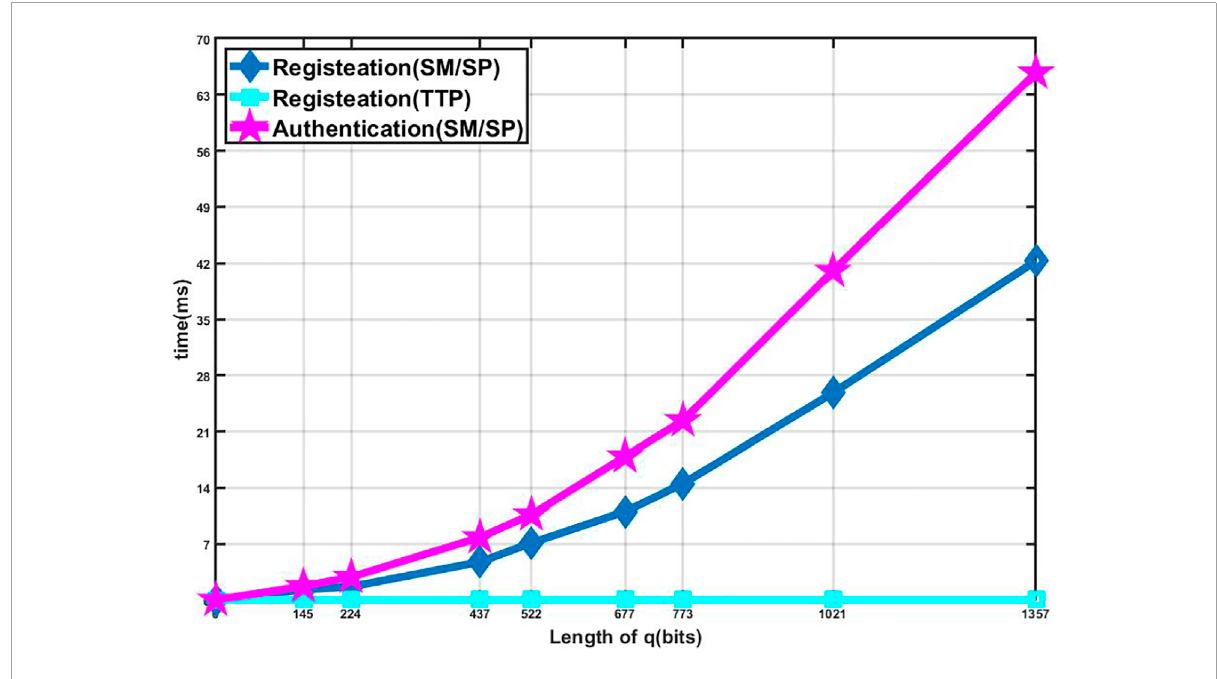
FIGURE 5 Time cost under different bit lengths of q .